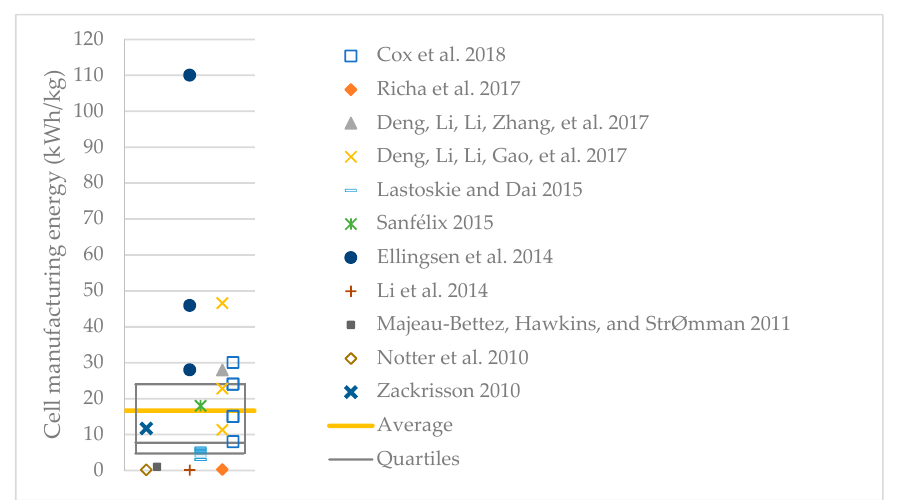
Figure 1. Cell manufacturing energy in the literature. The grey box shows the quartiles.